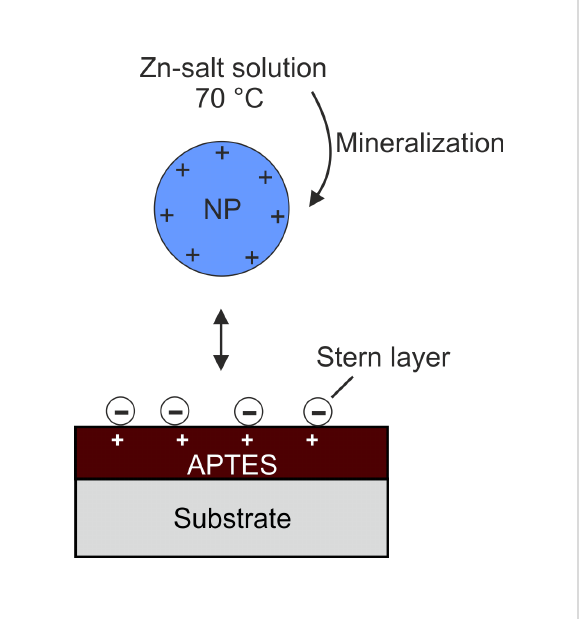
Figure 2: Deposition mechanism of mineralized ZnO nanoparticles on amino SAMs. The negative charges represent counterions attached to the positive surface charge (Stern layer) provided by protonated amino groups (–NH 3+